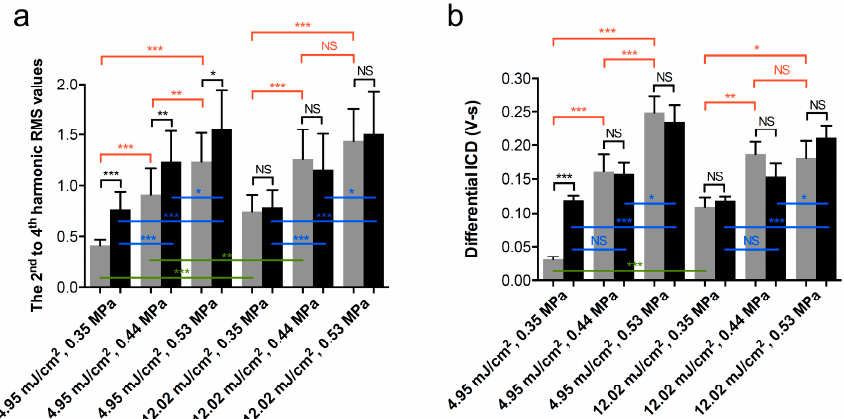
Figure 8. Comparison of vaporization and cavitation events under di ff erent parameter sets. ( a ) The 2 nd to 4 th harmonic RMS values and ( b ) di ff erential ICD values as a function of di ff erent exposure parameters. Gray columns, laser PRF = 10 Hz. Black columns, laser PRF = 20 Hz. Each column indicates the mean and SD from three individual experiments, n = 48. Student’s t -test was applied for the determination of the significant di ff erence between two sets of data. *, p < 0.05; **, p < 0.01; ***, p < 0.001; NS, no significance. Green lines denote the comparison of the two data sets between low and high laser fluence, only the three labeled groups display significant di ff erences. Black lines denote the comparison of the two data sets between low and high laser PRF. Red lines and blue lines denote the comparison of the two data sets between di ff erent acoustic PNPs in the groups of laser PRF of 10 Hz and 20 Hz, respectively.